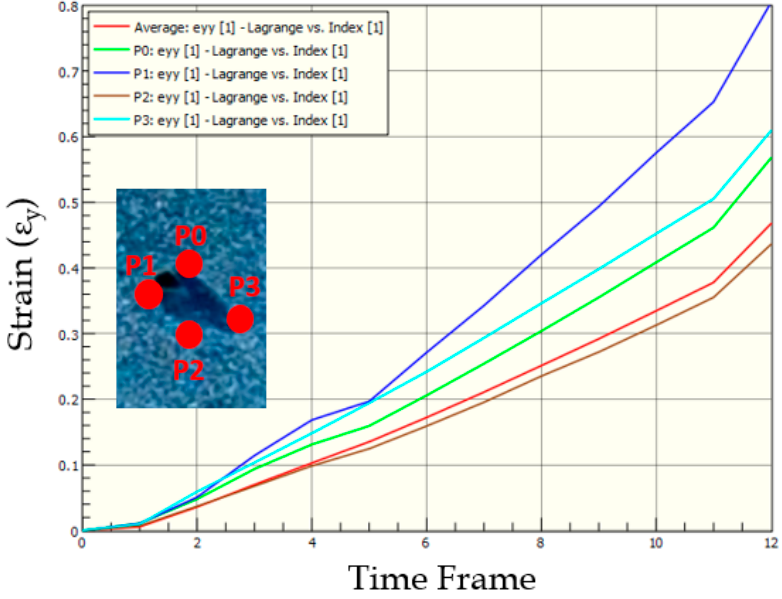
Figure 17. Average strain (y-axis) versus time frame (x-axis) measured using DIC from tensile test on the skin phantom specimen 5 with wound.